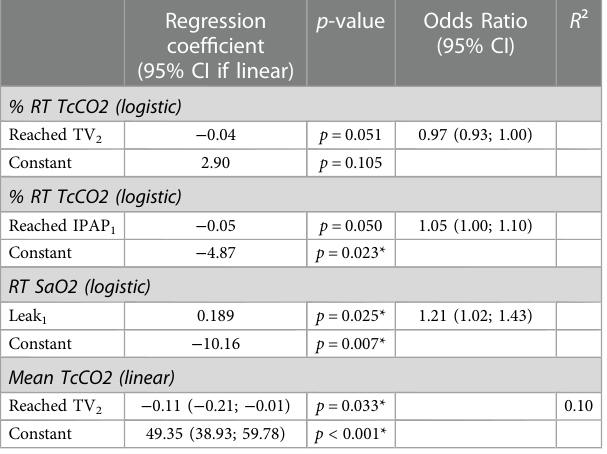
Figure 1 with an AUC of 84%. When looking to the test value of 42.16 L/min would result in a sensitivity of 83.3% and a speci fi city of 78.8%.